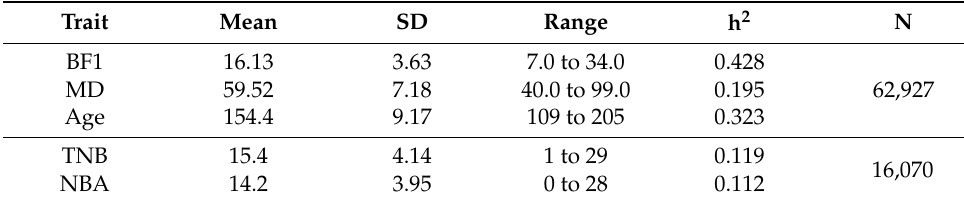
Table 1. The descriptive statistics of the whole dataset.